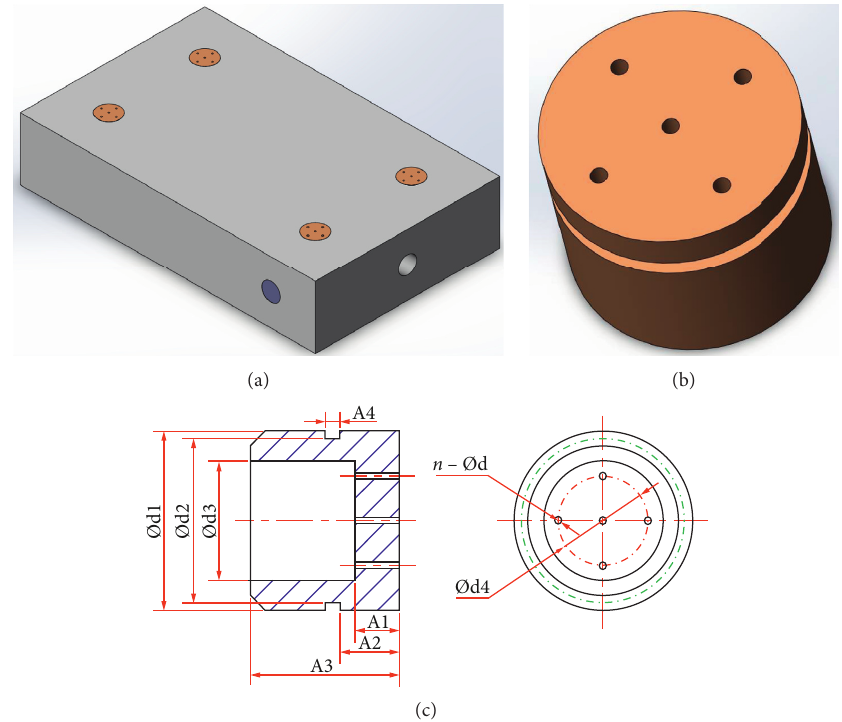
Figure 1: Schematic diagram of the physical model of aerostatic bearings with multihole integrated restrictor: (a) aerostatic bearing body; (b) multihole integrated restrictor; (c) structural chart of multihole integrated restrictor.